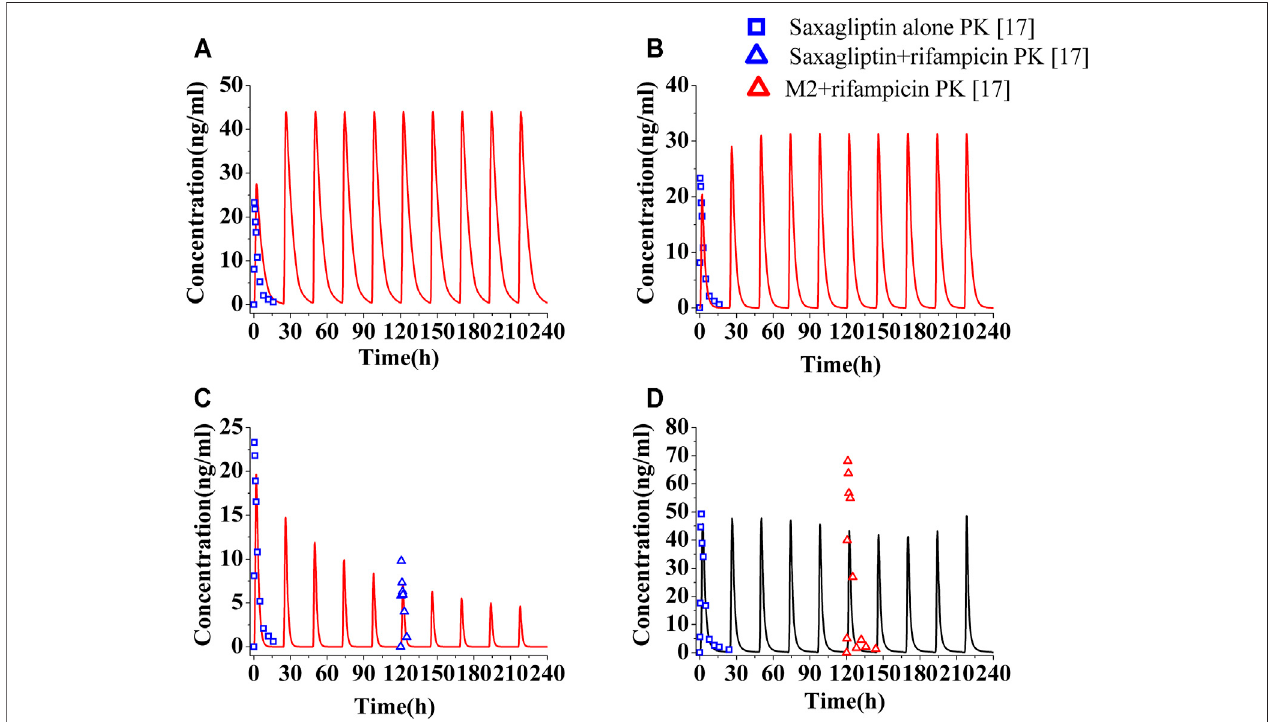
FIGURE 3 | Human plasma level of saxagliptin and M2 following coadministration of inhibitors or inducers. Human plasma pro fi les of saxagliptin with ketoconazole ( A , 200 ° mg,twicedaily),withdelavirdine( B ,400 ° mg,twicedaily)andrifampicin( C ,600 ° mg,oncedaily)andofM2withrifampicin (D) .Thebluesquares,blueup-triangles,andredup- trianglesrefer toobserved PK data ofsaxagliptin withoutinhibitors/inducers( □ ) and observed PK data of saxagliptin ( △ ) and M2( △ ) with rifampicin on thesixth day,